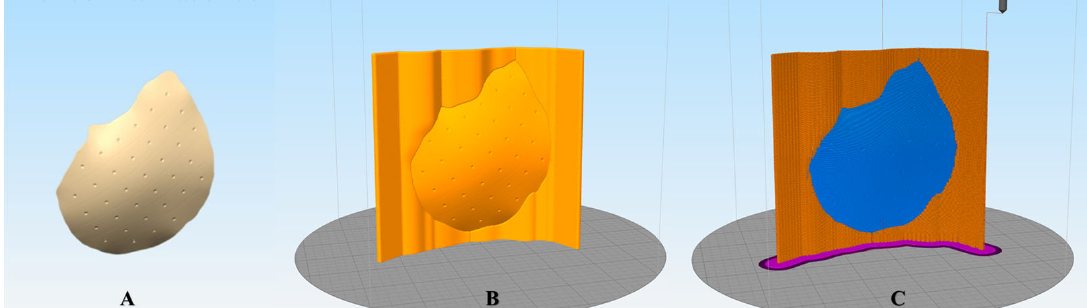
Figure 2. Schematic representation of the pre-processing steps for fabricating polyetheretherketone (PEEK) customized cranial implants. ( A ) Virtually designed customized cranial implant. ( B ) Cranial implant with support structures positioned vertically on the printer’s build platform in printing